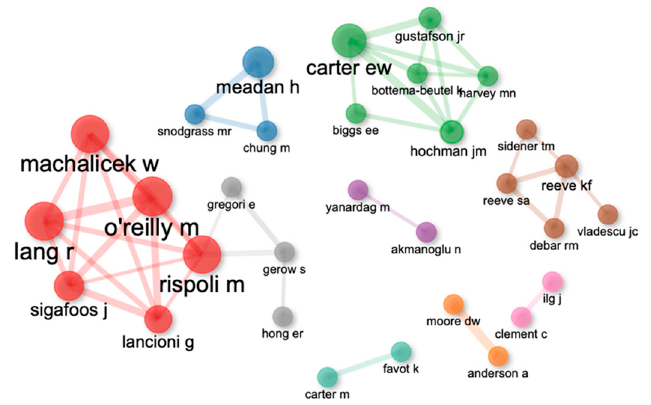
Figure 4. Co-authorship networks.